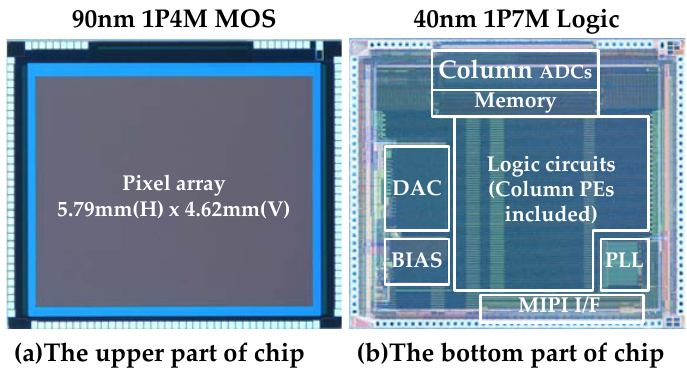
Figure 12. Photomicrograph of the chip. ( a )The upper chip consists of only pixels; ( b ) the lower chip, using an advanced logic process, contains large amounts of logic.